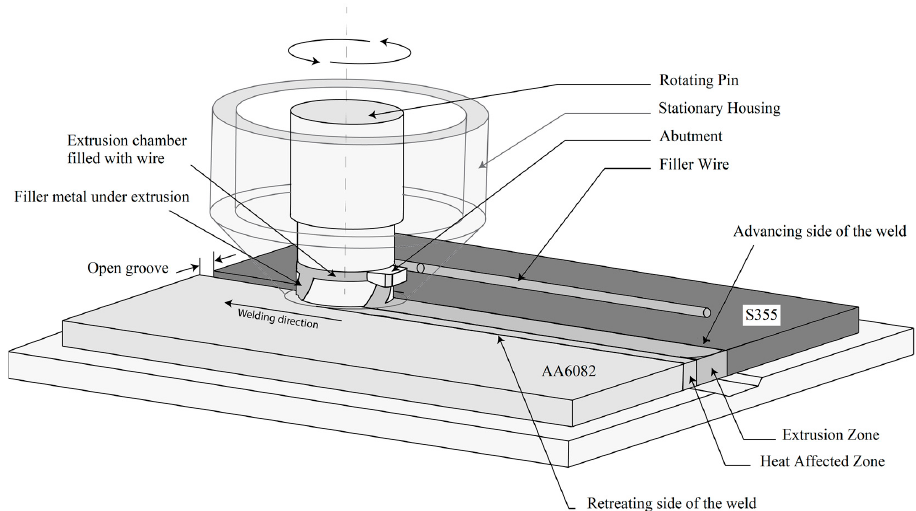
Figure 4. Schematic illustration of the HYB process applied to dissimilar metals with its main parts being involved in the joining process.